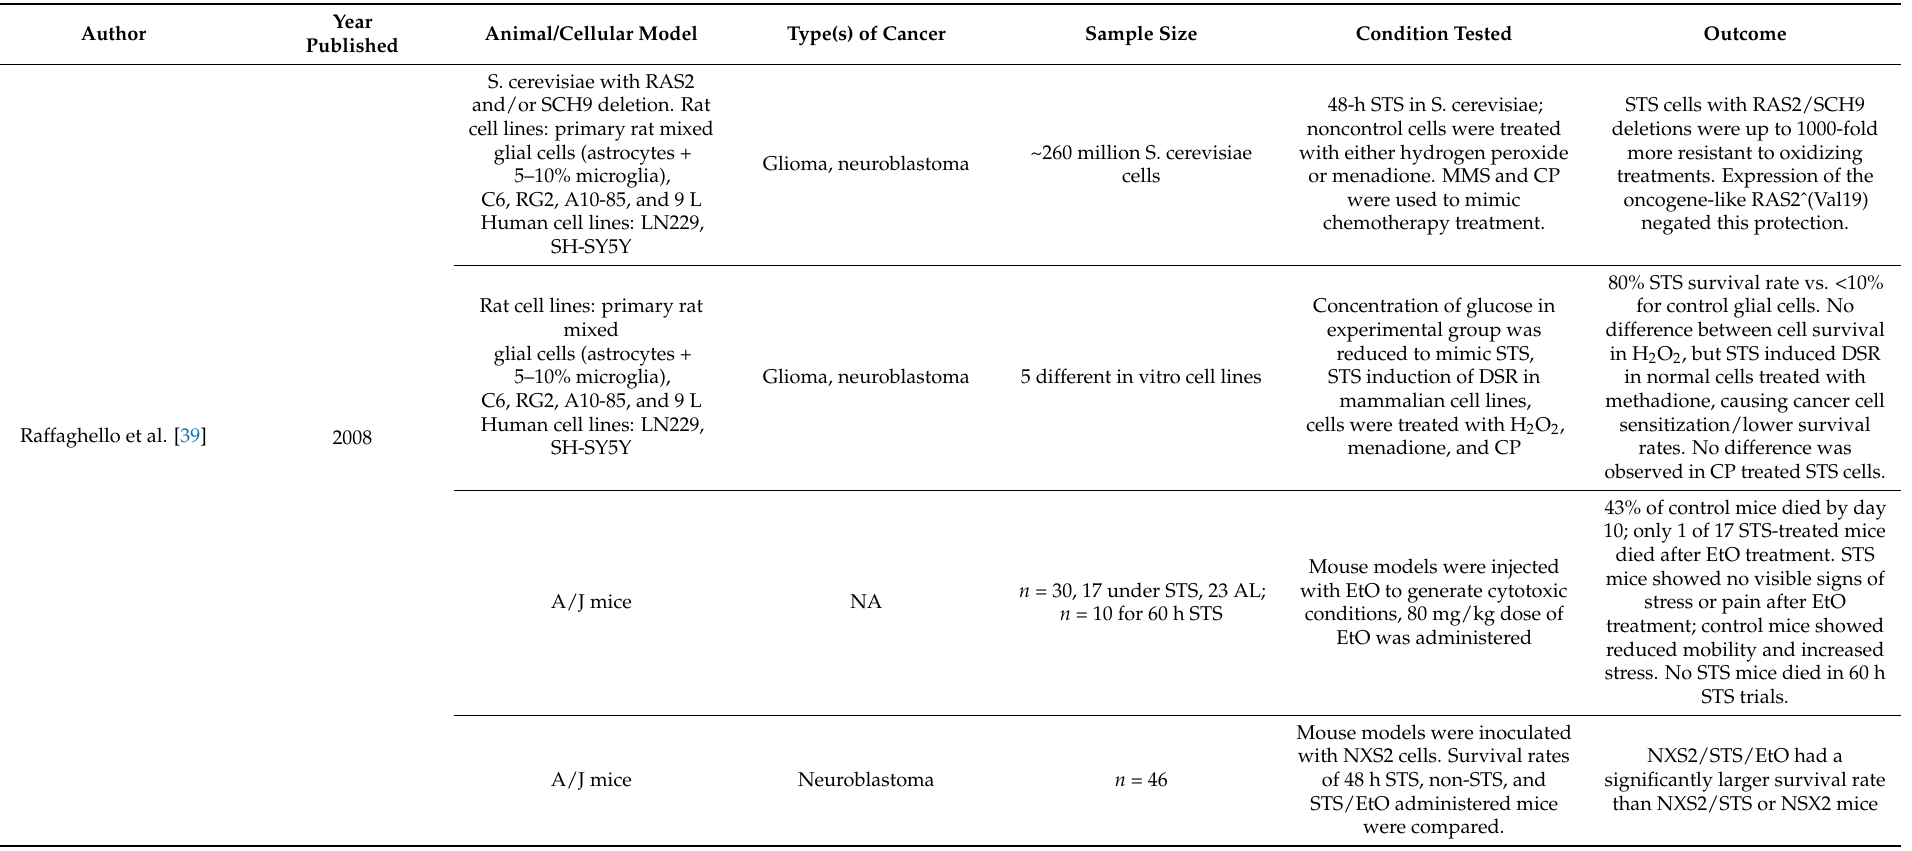
Table 2. Pre-clinical studies examining the effect of dietary interventions (CR, IF, and KD) in animal models undergoing chemotherapy and/or